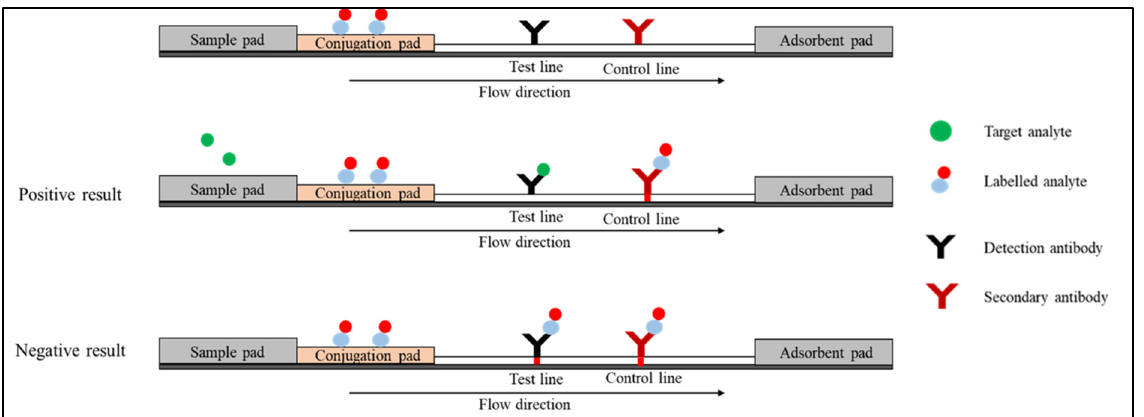
Figure 3. Schematic diagram shows the competitive format (first arrangement).